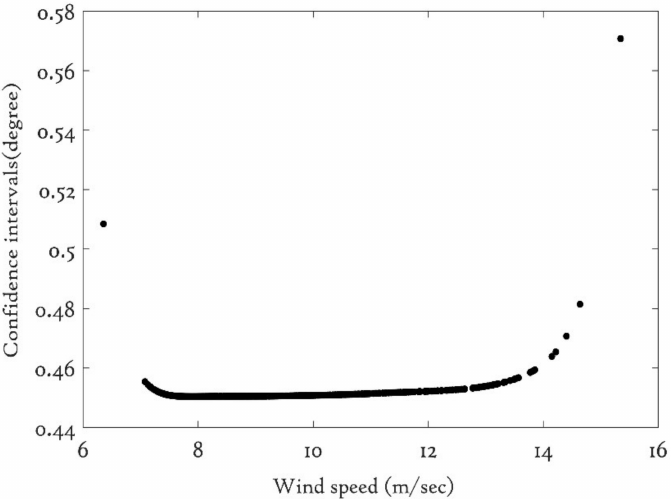
Figure 14. GP blade curve